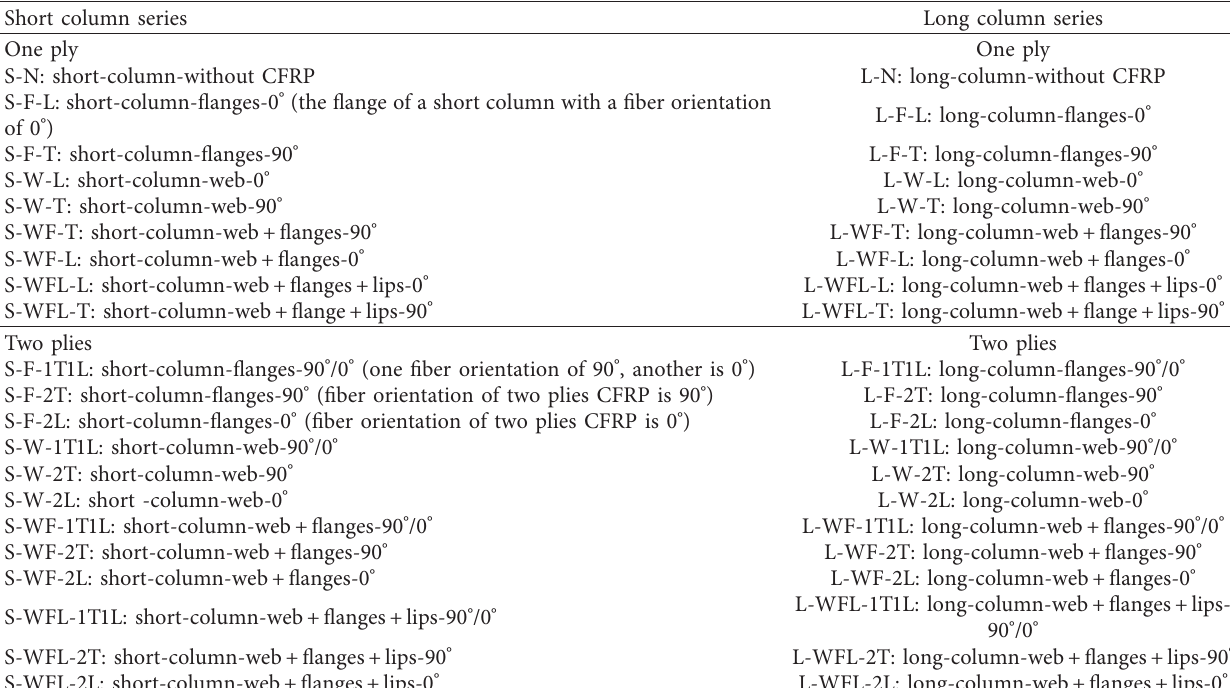
Figure 8: Fiber orientation diagram [8]. (a) Fiber orientation-transverse. (b) Fiber orientation-longitudinal. Table 4: Component